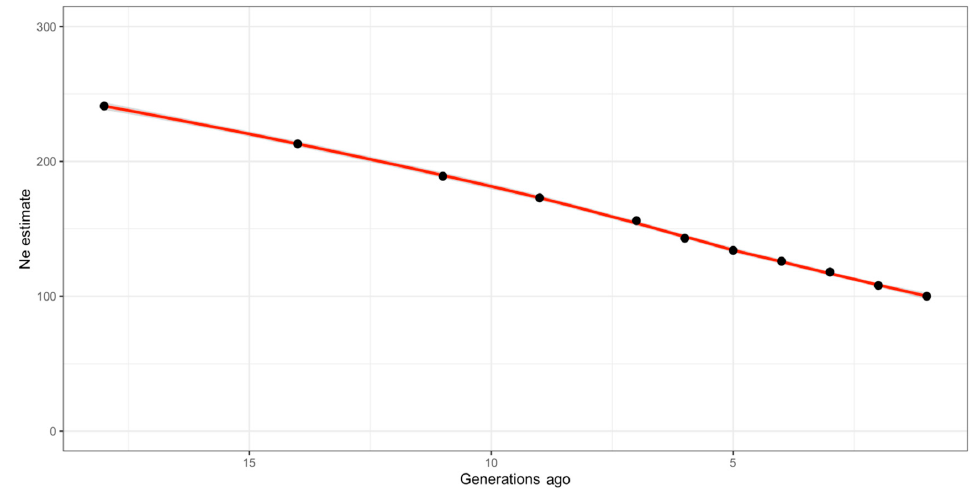
Figure 4. Estimation of genomic effective population size (Ne) traced back to 18 generations